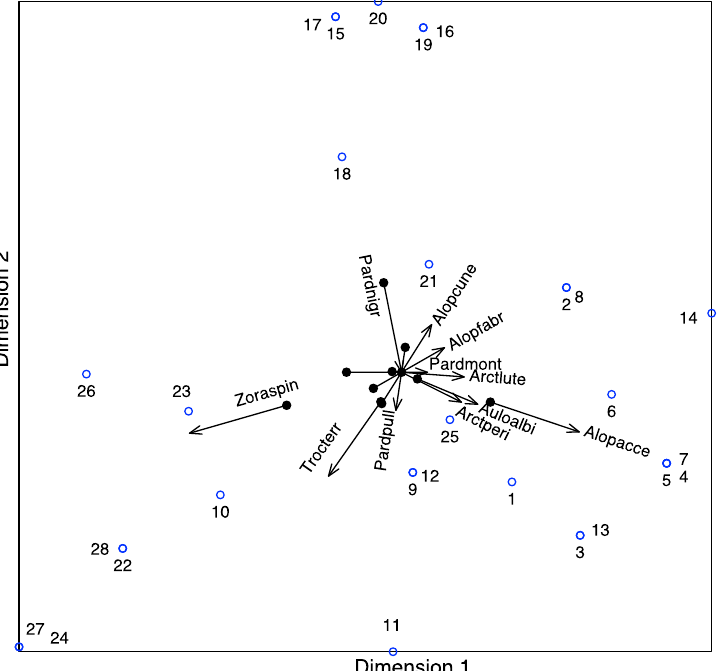
Figure 4. Typical logistic biplot representation with arrows for the binary variables. The data used for the biplot is the binary matrix of the second example in the next